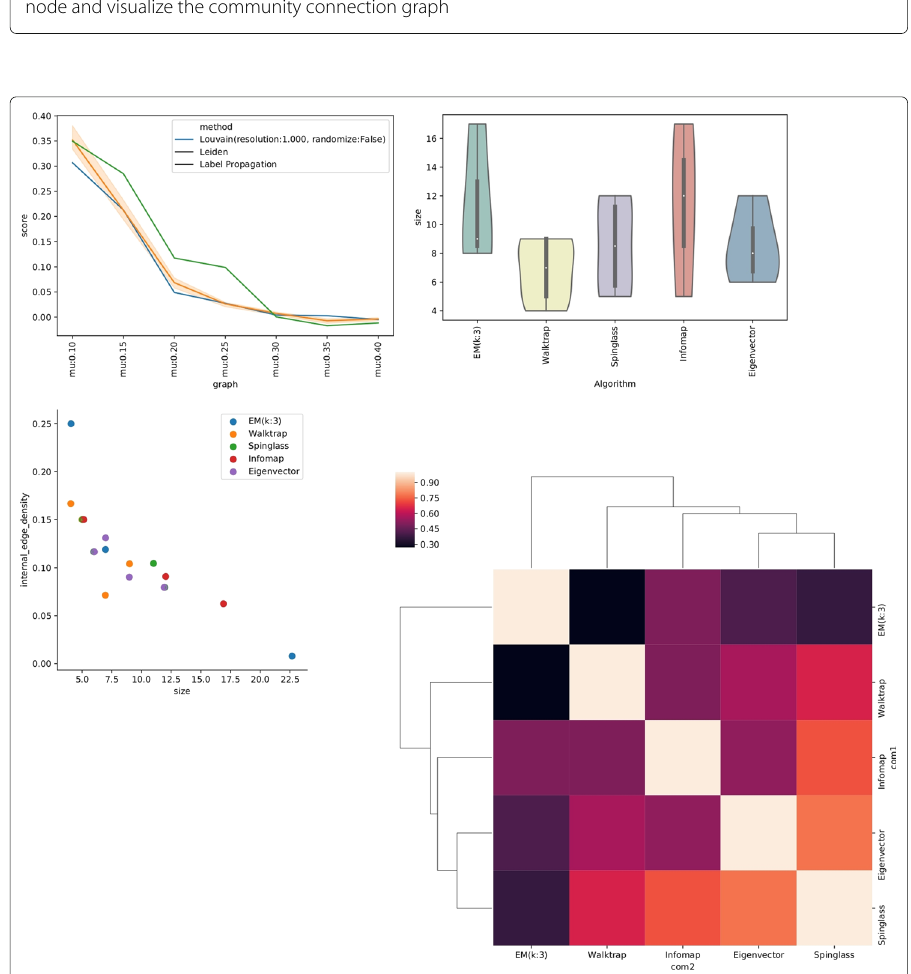
Fig. 2 Visual Analitycs. Analytics plots for CD algorithm. First line: (left) is the plot of the scores (in this case obtained with adjusted_mutual_information ) obtained by a list of methods on a list of graphs (on LFR benchmark graphs (Lancichinetti et al. 2008)); (right) is the plot of the distribution of a property (e.g. size ) among all communities for a clustering, or a list of clusterings on the Zachary’s Karate Club graph. Second line: (left) is the plot of the relation between the two functions size and internal_edge_density of CD algorithms on the Zachary’s Karate Club graph; (right) is the plot of the similarity matrix between a list of clusterings, using the provided scoring function (in this case obtained with adjusted_mutual_information ) on the Zachary’s Karate Club